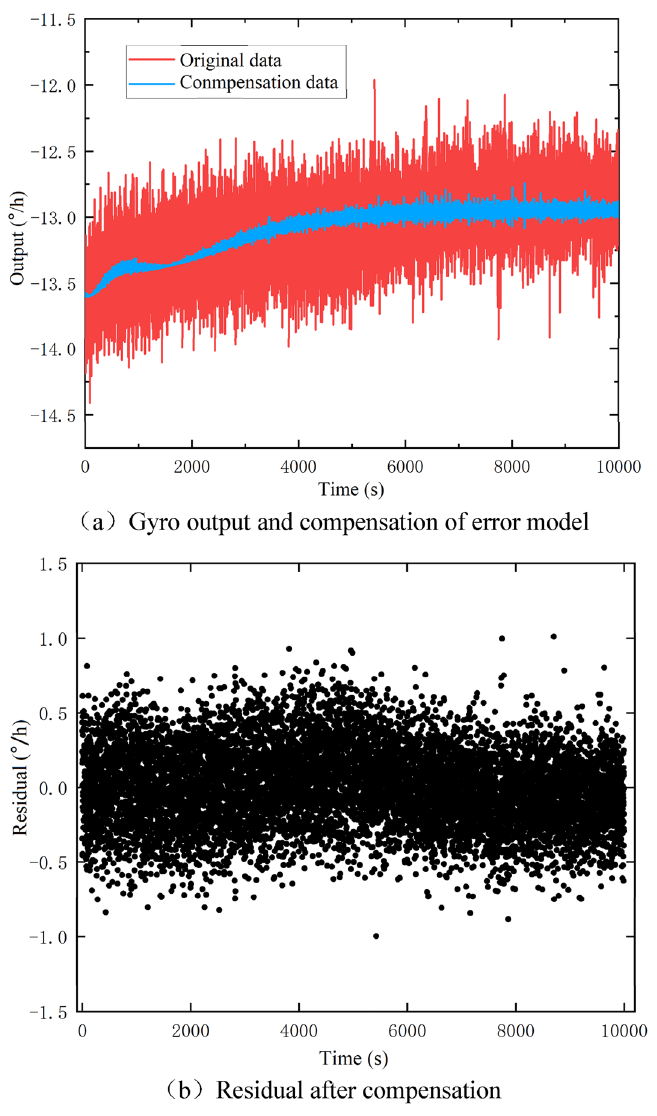
Figure 8. Compensation effect of temperature-rising